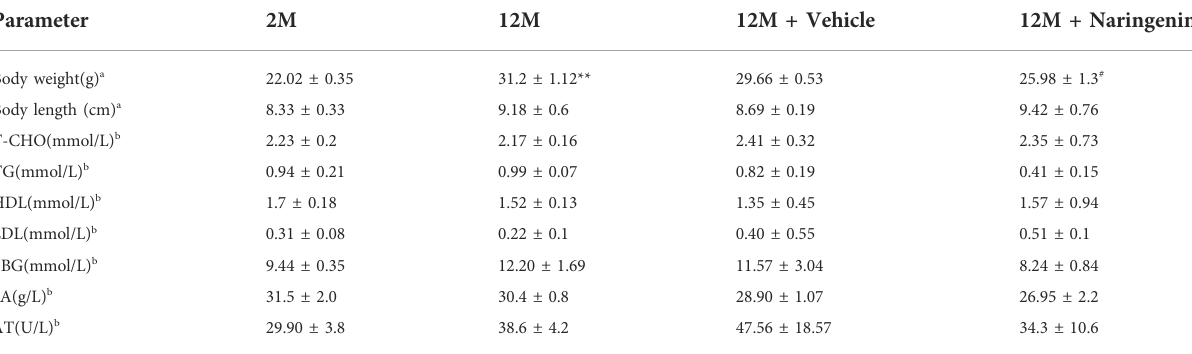
TABLE 1 The effect of Nar on biochemical and physiological indices in mice.Shown here are the means ± SEM of the data collected from three to fi ve animals in each experimental group.